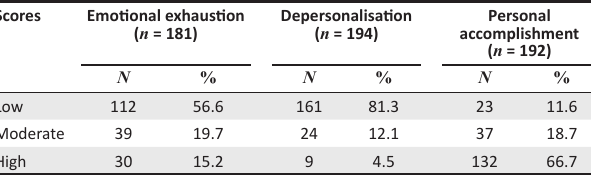
TABLE 3: Burnout domains by categories. Scores Emotional exhaustion Depersonalisation ( n = 181) ( n = 194)